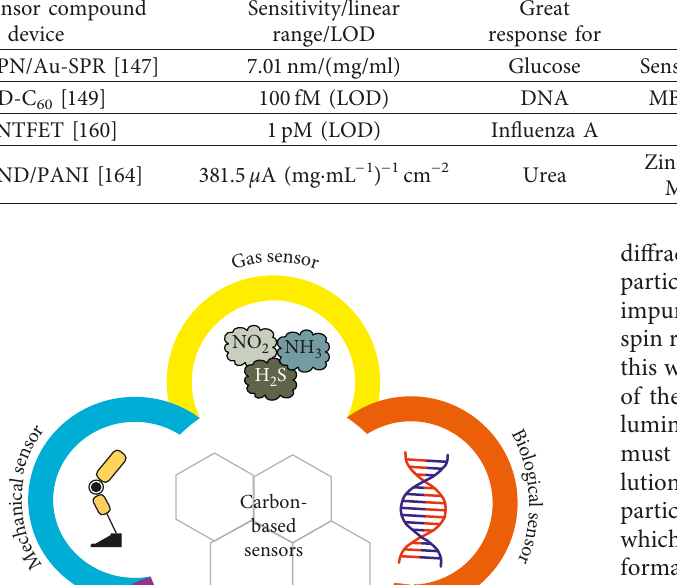
Table 7: Comparison between some of the biomolecules sensor systems described in this review and those already reported. Sensor compound or device